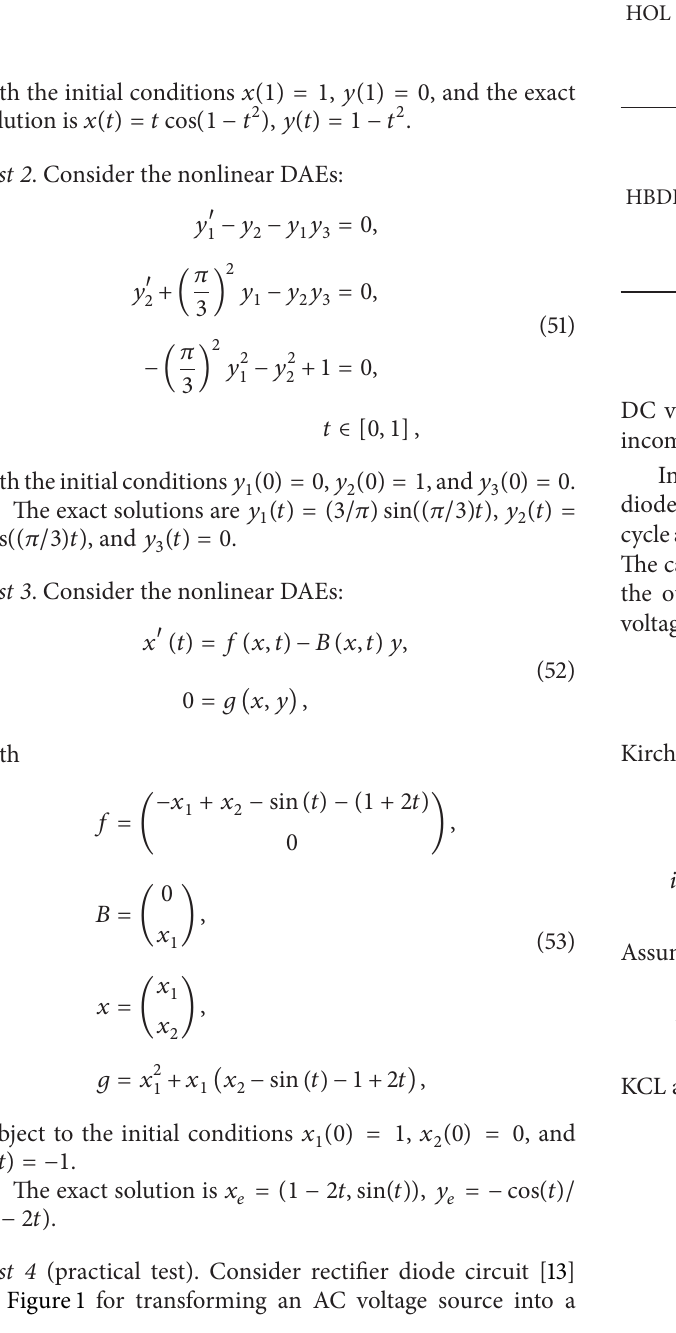
Figure 1: Rectifier circuit.